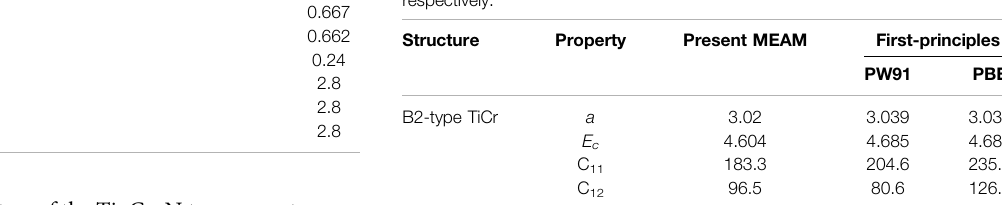
TABLE 4 | Comparison of the lattice parameter, cohesive energy and elastic constants of B2-type TiCr calculated by the present developed 2NN MEAM potentials with the fi rst-principles calculation results. The units of the lattice parameter a, cohesive energy E c and elastic constants are Å, eV and GPa,